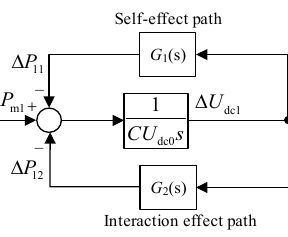
Figure 6. Diagram for illustration the feedback power components to VSC1 affected by itself and the interaction with VSC2.